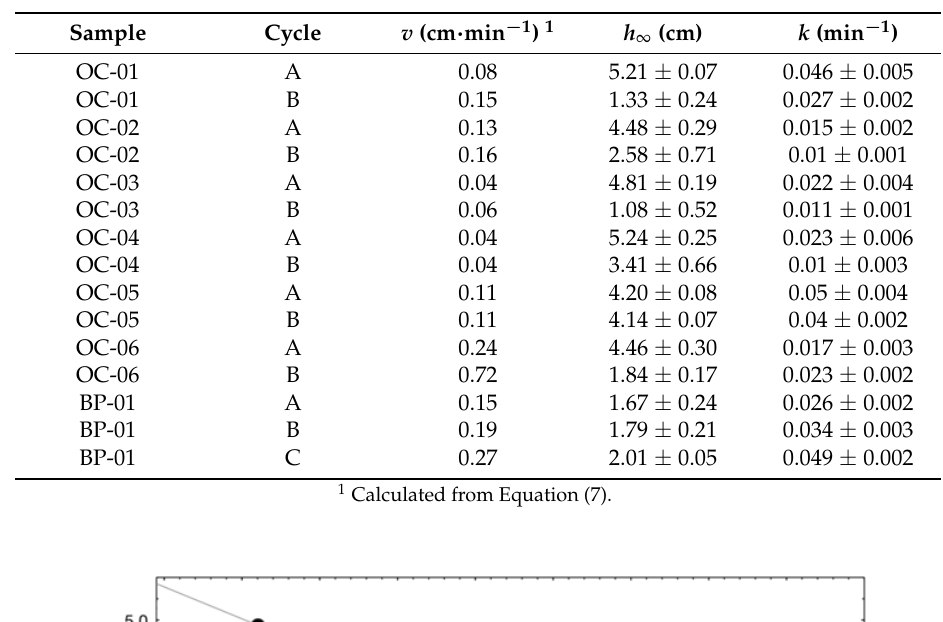
Table 3. Calculated v values and estimates for h ∞ and k based on inverse modelling of settling time course data.